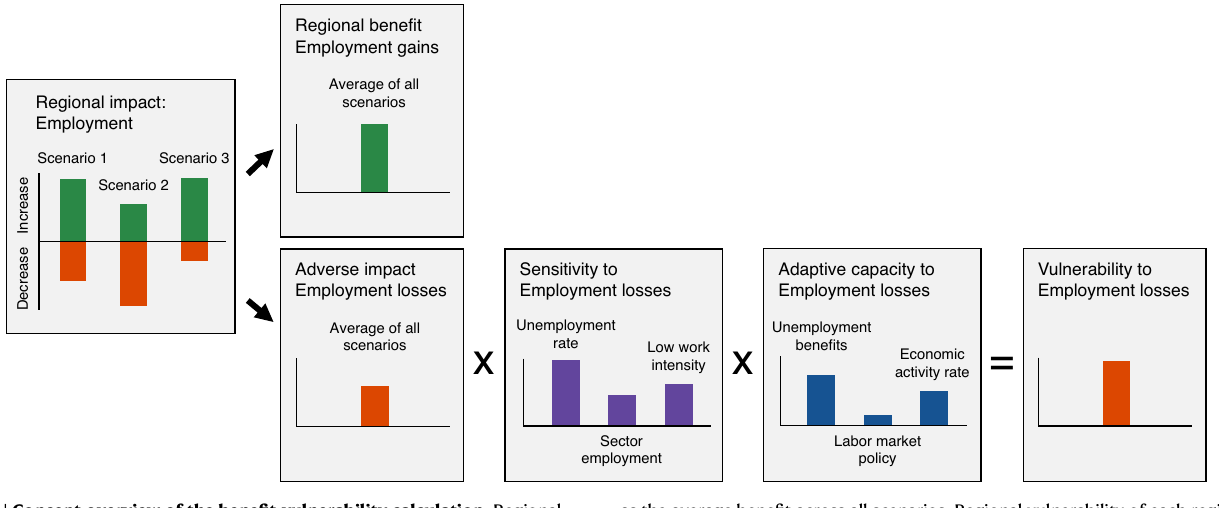
as the average bene fi t across all scenarios. Regional vulnerability of each region is computed with Eq. (2) that combines average adverse impact across all scenarios with three impact-speci fi c and equally weighted indicators of sensitivity and adaptive